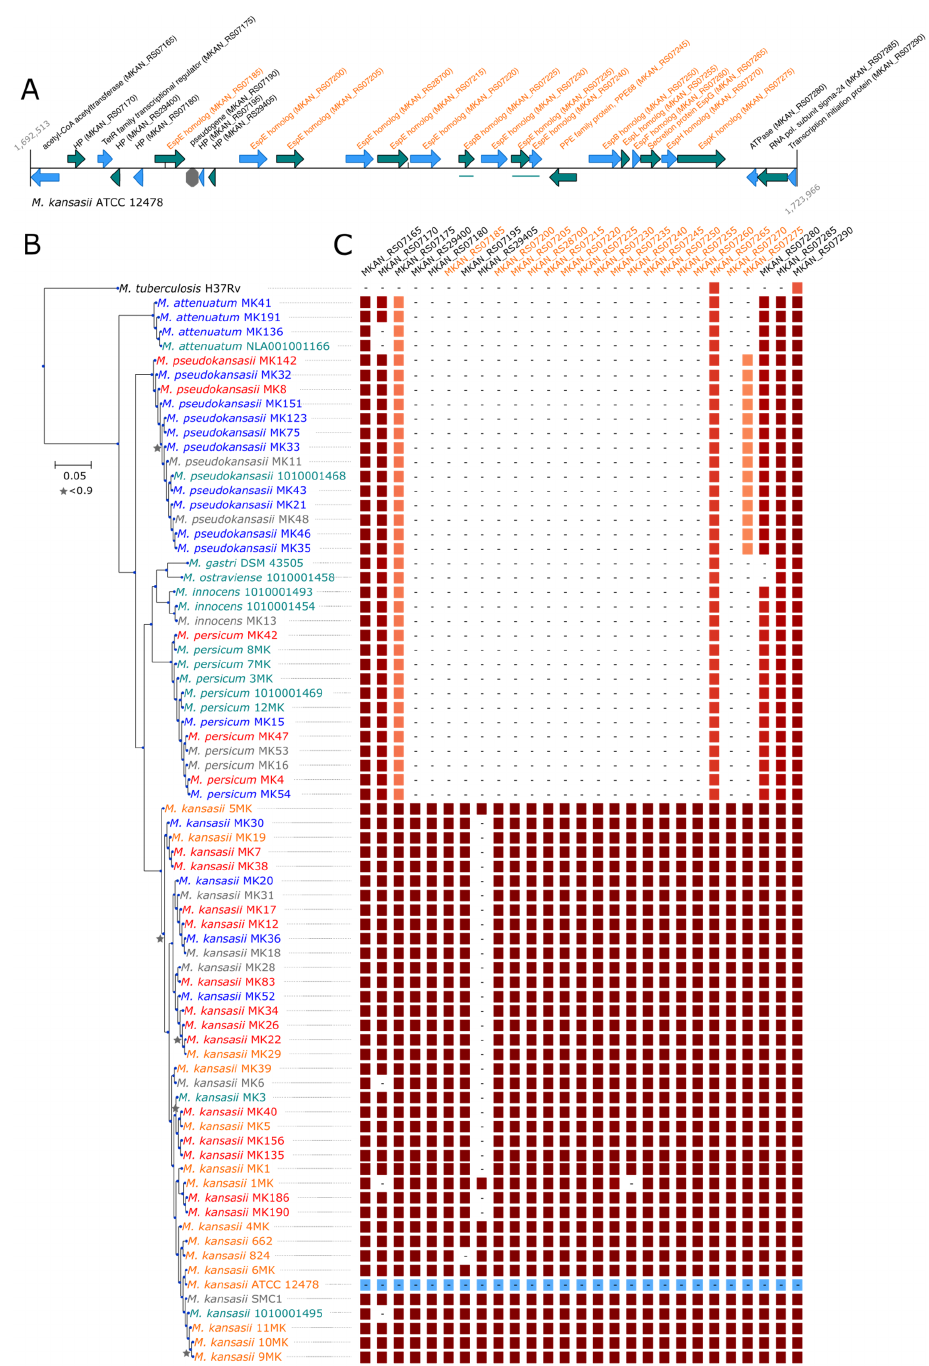
Figure 2. M. kansasii -specific genomic island encodes Type-VII secretion system effectors. ( A ) Locus is displayed for M. kansasii ATCC 12478, as a reference genome. Products mentioning “homolog” were manually annotated based on comparison to other genomes. Esp, ESX-1 secreted protein. All genes related to the type-VII secretion system are highlighted in orange. ( B ) Maximum- likelihood phylogeny based on the concatenated amino acid alignments of single-copy orthologous genes forming the core genome. Node supports based on the Shimodaira-Hasegawa (SH) test are indicated with a star when below 0.9. The scale bar represents the number of amino acid substitutions per site alongside the branches. Species pathogenicity is color-coded according to the results reported in Table 1. Red = 1 = pathogenic, Orange = 2 = probably pathogenic, Grey = 3 = unknown, Green = 4 = probably non-pathogenic, Blue = 5 = non-pathogenic. ( C ) The putative genomic island is specific to the M. kansasii species. The amino acid identity with the reference M. kansasii strain ATCC 12478 sequence (in blue) is